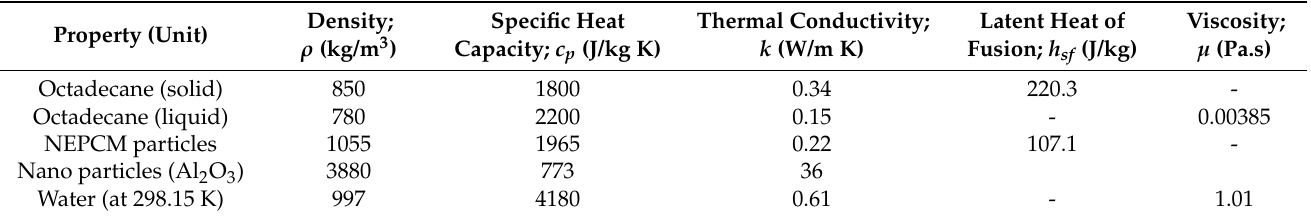
Table 1. Thermophysical properties of coolant components